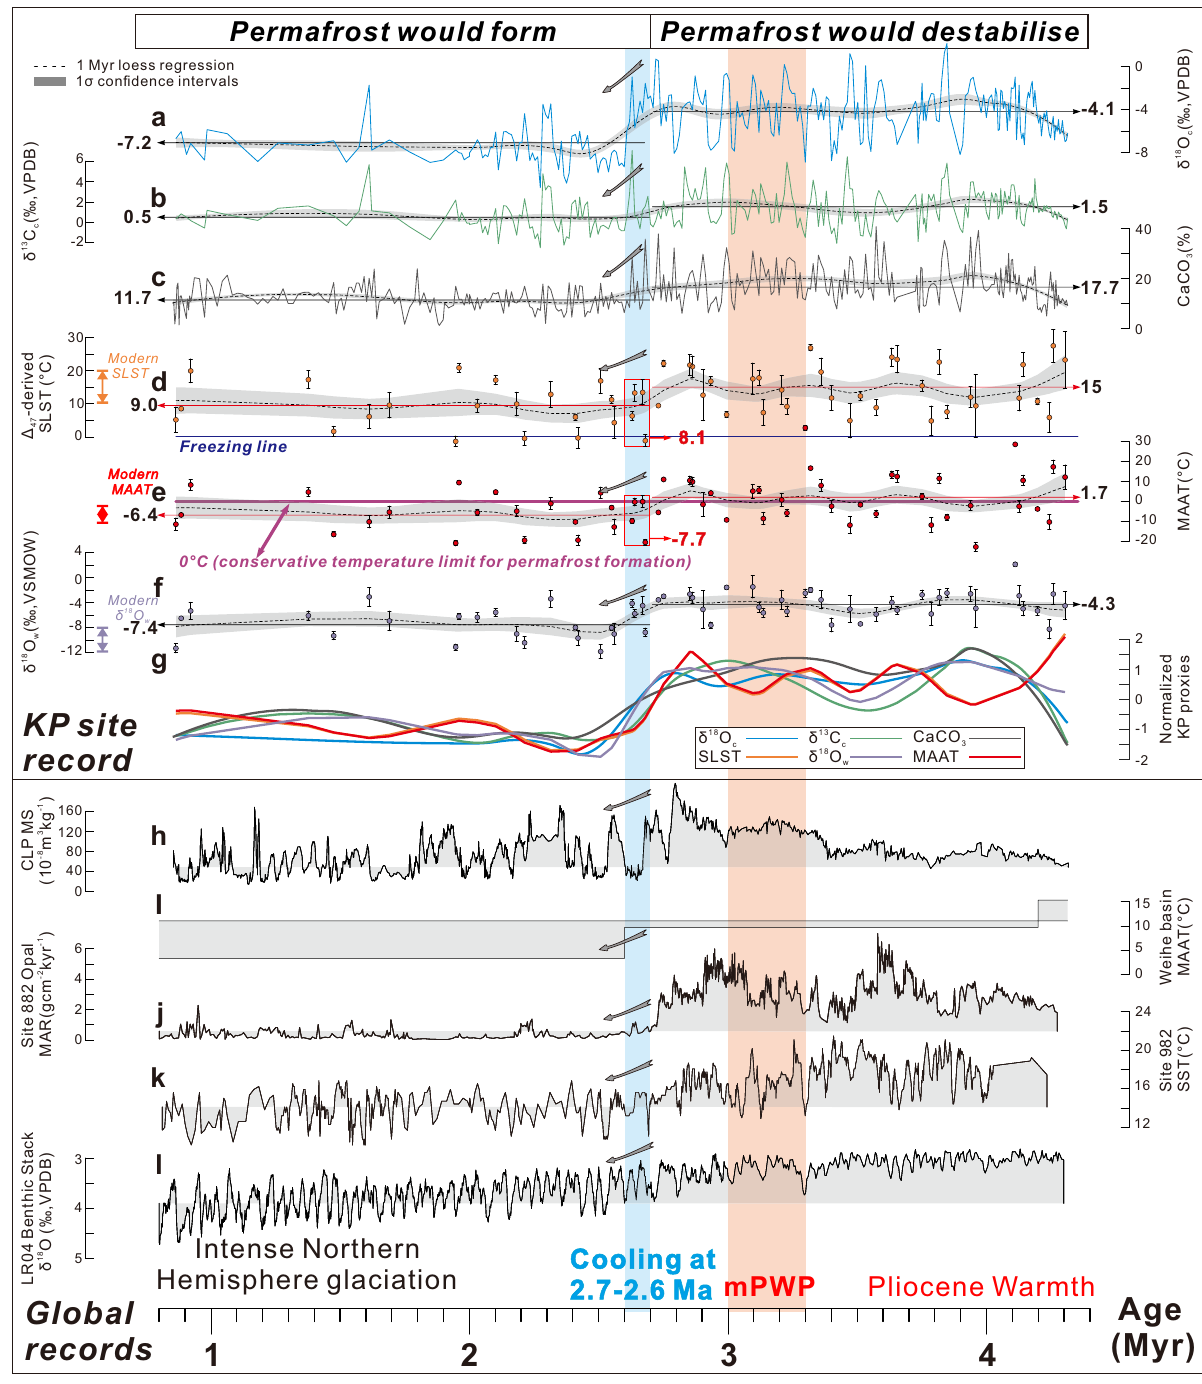
Collectively, multiple proxies indicate paleoclimate change at 2.7 – 2.6 Ma at the KP site in the northern Tibetan Plateau, likely related to regional cooling that was coincident with the intensi fi cation of the Northern Hemisphere Glaciation (NHG) (Fig. 3h – j) 16 . An ~8.1 °C decrease in local MAAT at 2.7 – 2.6 Ma is derived from the Δ 47 paleothermometer and transfer function that relates late surface temperature to MAAT. Global permafrost stability and affected carbon . Global per- mafrost is mainly distributed in circumarctic and alpine regions, with the Tibetan Plateau being the largest alpine